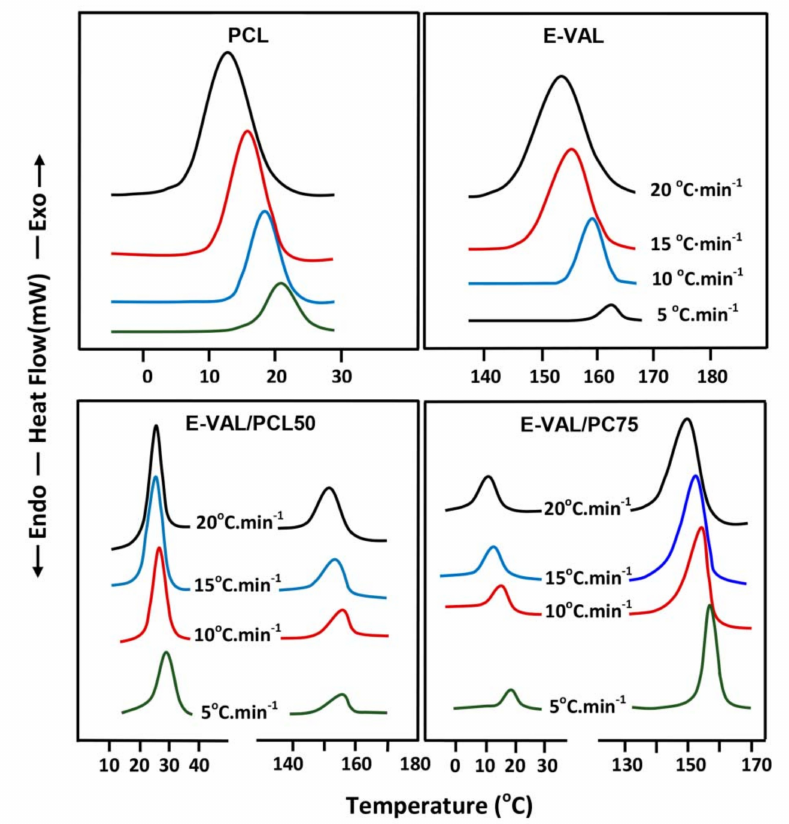
Figure 6. Variation of the crystallization temperatures of E-VAL, PCL, and E-VAL/PCL blends containing 25 and 75 wt% PCL vs. the cooling